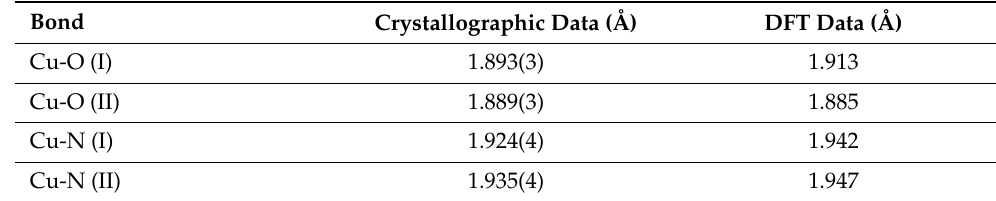
Table 2. The crystallographic and DFT data for complex 3